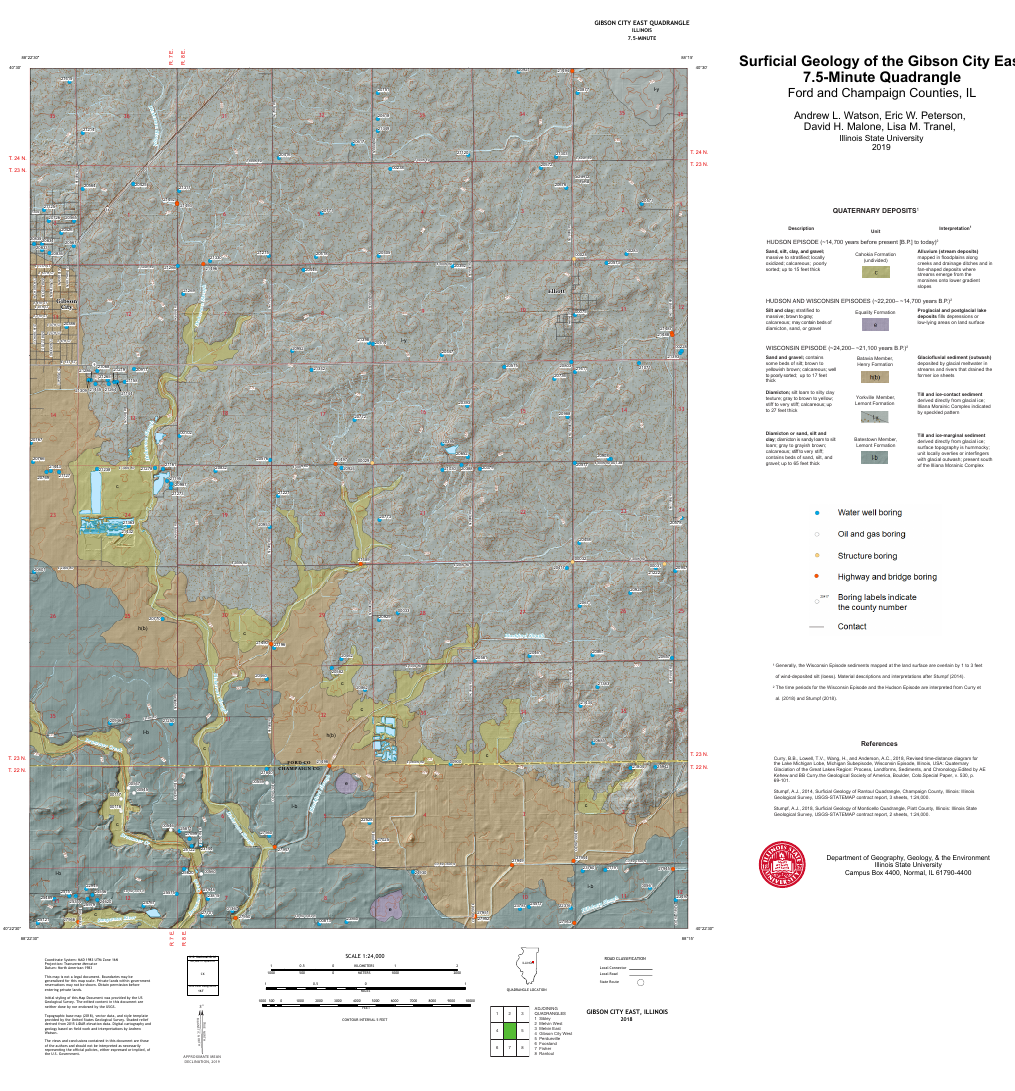
Figure 3. Surficial geologic map of the Gibson City East Quadrangle. A higher resolution pdf has been provided as a supplementary